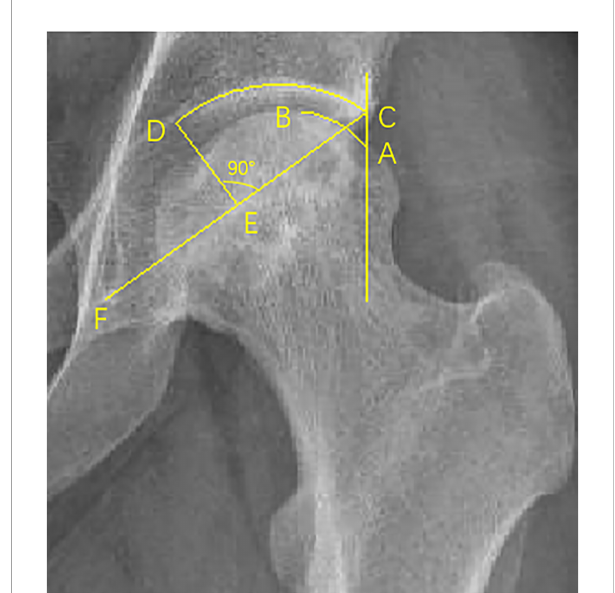
boundary of the necrotic area involving the wall of the femoral head. Length (A-B) represents the contour length of the femoral